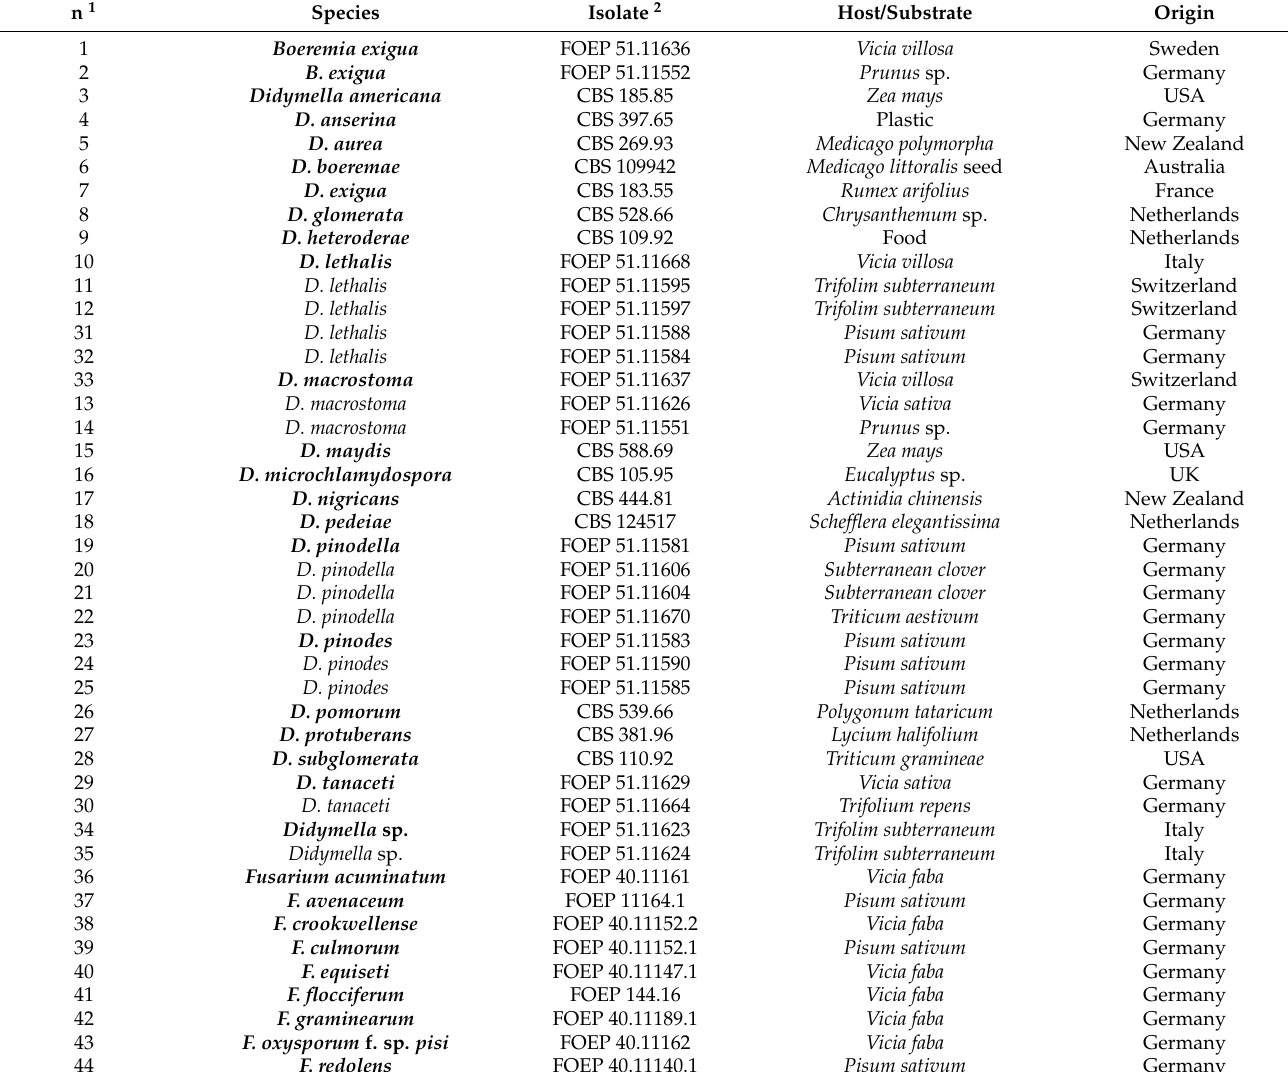
Table 1. List of fungal strains used in this study. Different species are highlighted in